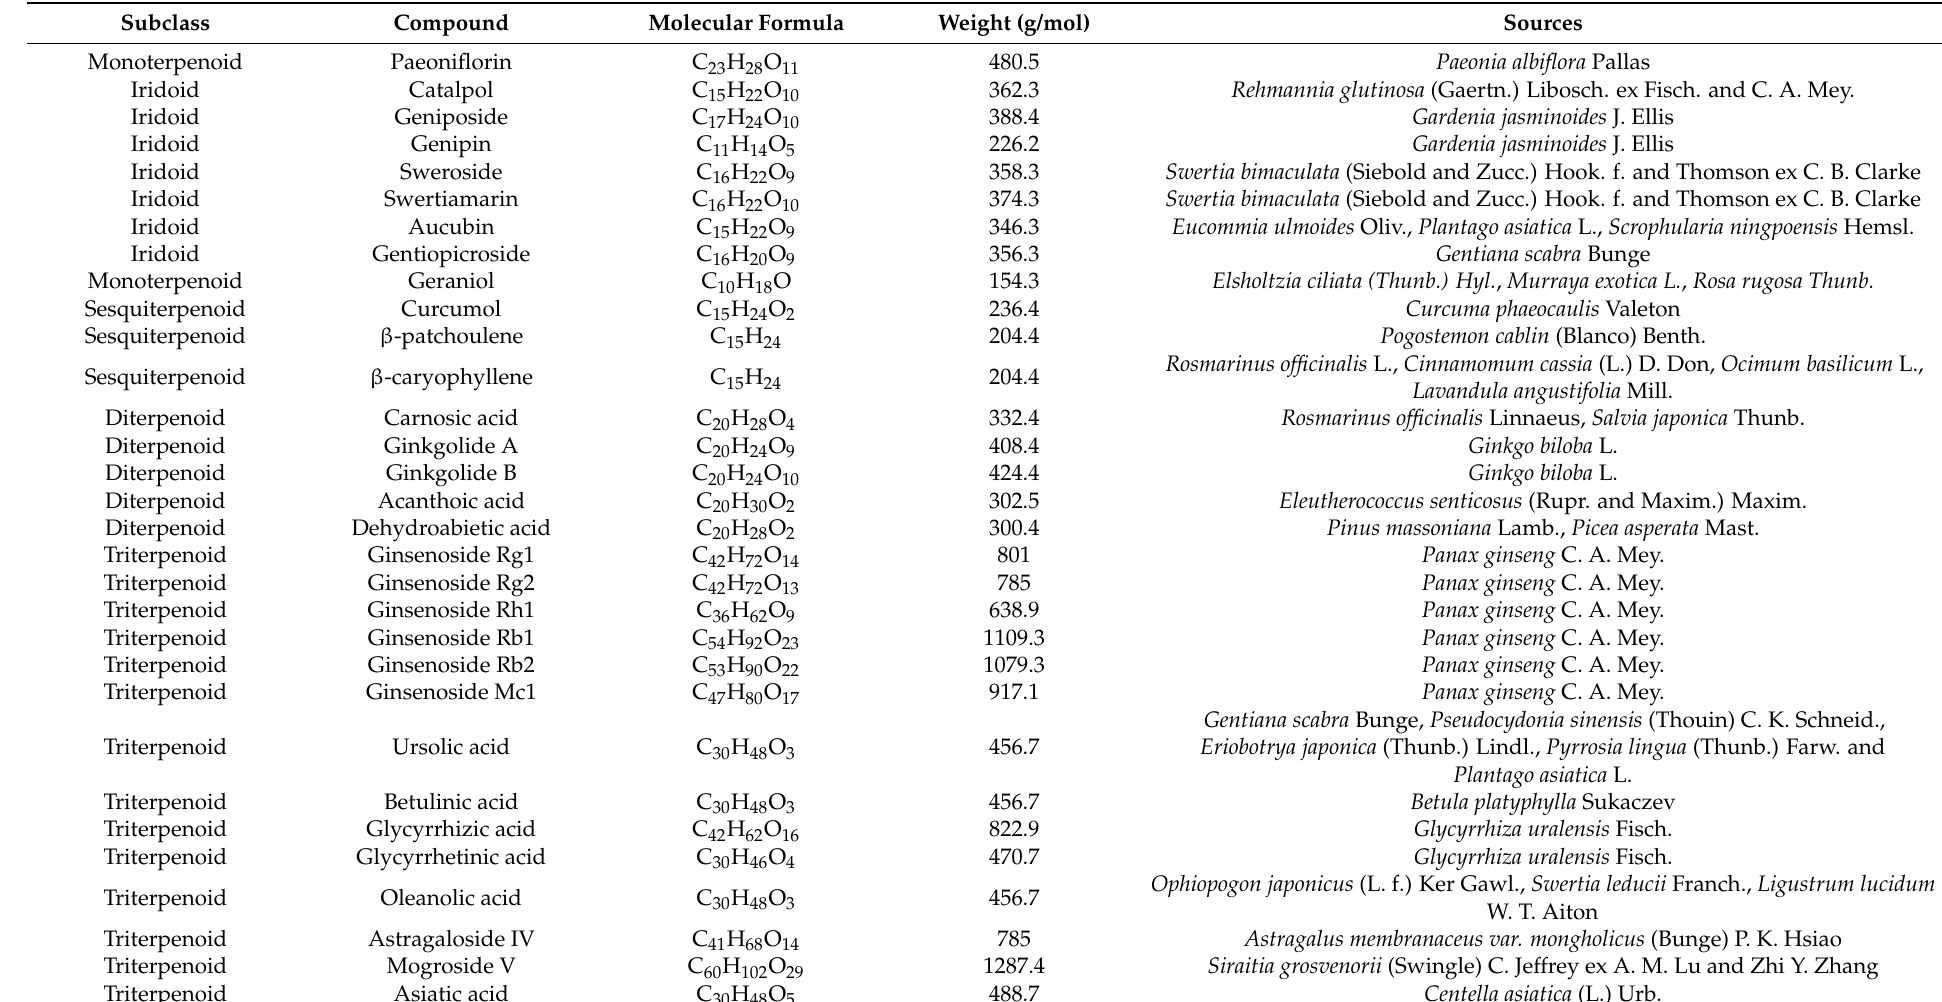
Table 1. Introduction to the basic information of